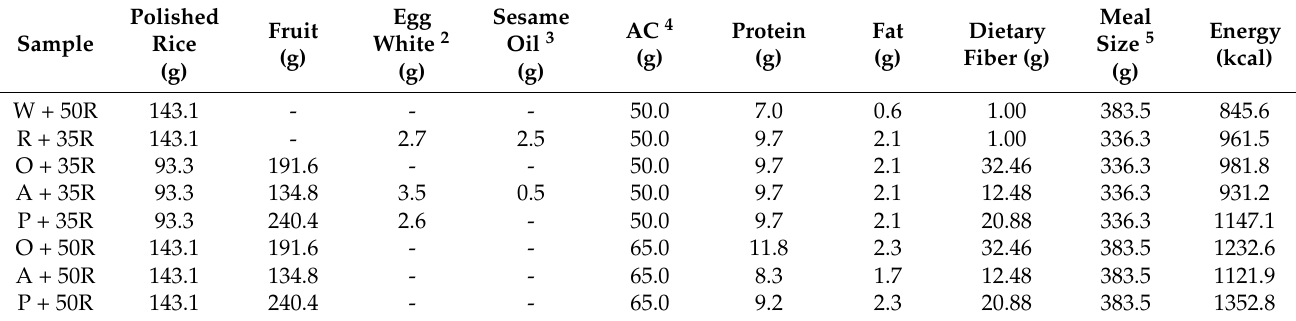
Table 1. Composition and nutrient content of test meals (per serving) 1